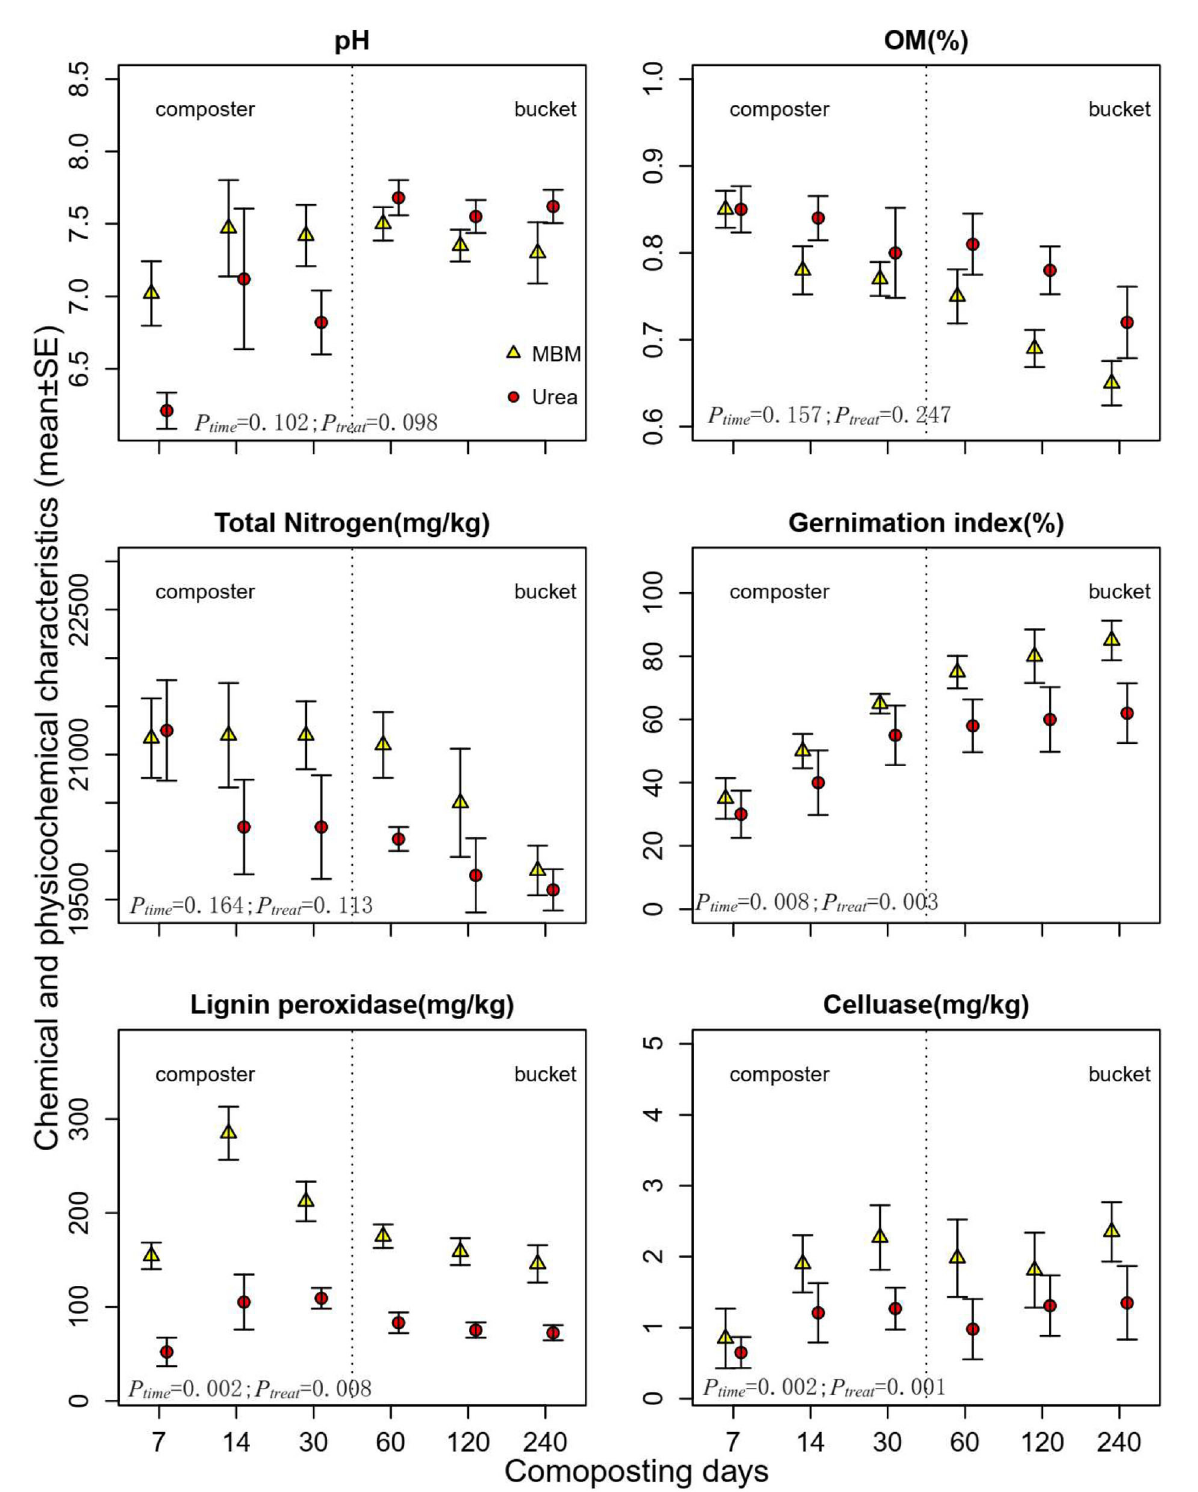
FIGURE2 Dynamics of pH, organic matter content (OM%), germination index, total nitrogen, lignin peroxidase, cellulase, and composting process. MBM, asparagus straw with additive meat and bone meal; urea; asparagus straw with additive urea. Error bars are standard deviations of the means of